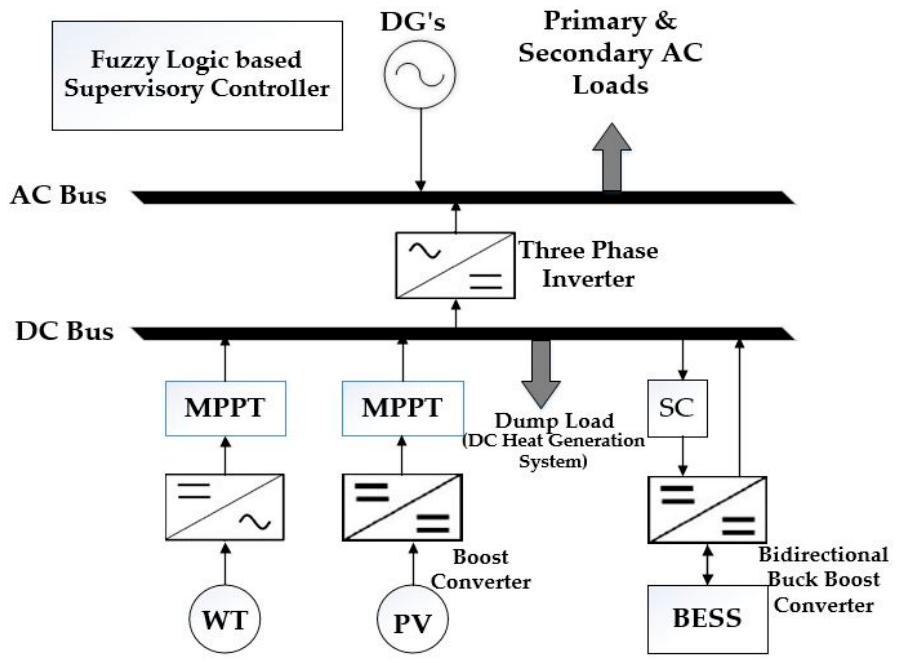
Figure 1. Proposed hybrid microgrid with fuzzy-based frequency and voltage controller.